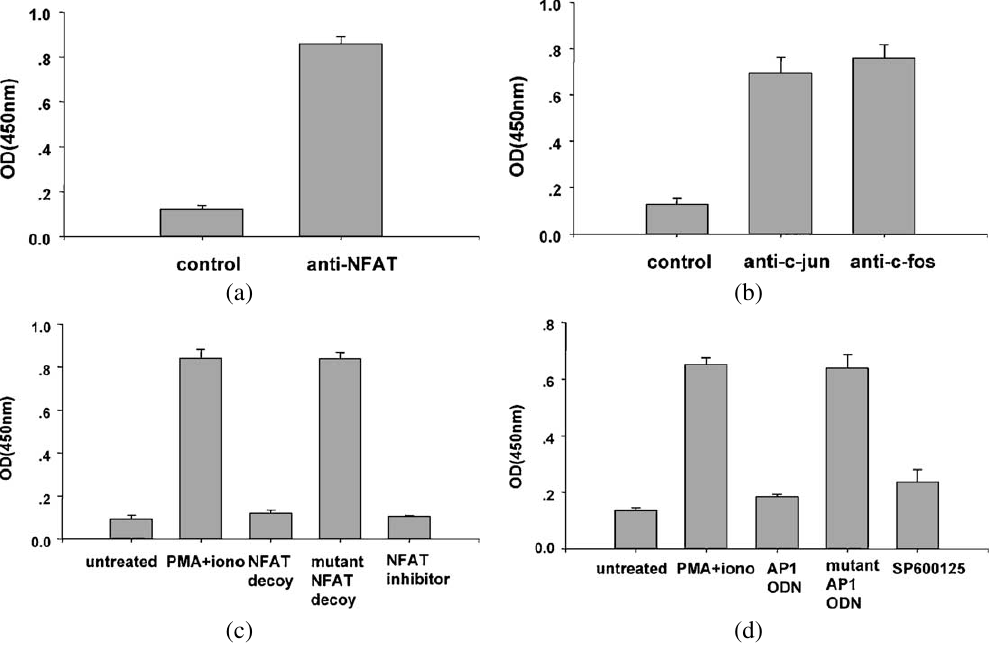
Fig. 3C. Transcriptional factor-DNA binding assay. (a) The binding of transcript factors NFAT with the probes containing NFAT binding sites at promoter G. (b) The binding of transcript factor AP1 (C-fos and C-jun) with the probe containing AP1 binding site at promoter G. For both (a) and (b), nuclear lysate was prepared from PMA/Iono stimulated K562 cells as indicated in material and methods. The binding assay was performed as illustrated in Fig. 3C, samples without primary antibody were used as control. (c) The binding of NFAT to its consensus sequence can be significantly inhibited by NAFT inhibitor or NFAT decoy ODN. Two hours before the PMA/Iono stimulation, cells were treated with NFAT inhibitor or transfected with NFAT decoy ODN. Two hours after the PMA/Iono stimulation, the nuclear lysate from the cells were prepared, and the DNA binding assay was performed as indicated above. (d) The binding of C-jun (component of AP1) to AP1 consensus sequence in the promoter G can be significantly inhibited by AP1 inhibitor or AP1 decoy ODN. Two hours before the PMA/Iono stimulation, cells were treated with AP1 inhibitor or transfected with AP1 decoy ODN. Two hours after the PMA/Iono stimulation, the nuclear lysate from the cells were prepared, and the DNA binding assay was performed as indicated above. Columns and bars represent the mean and standard deviation, respectively. All the values were obtained from 3 independent experiments.